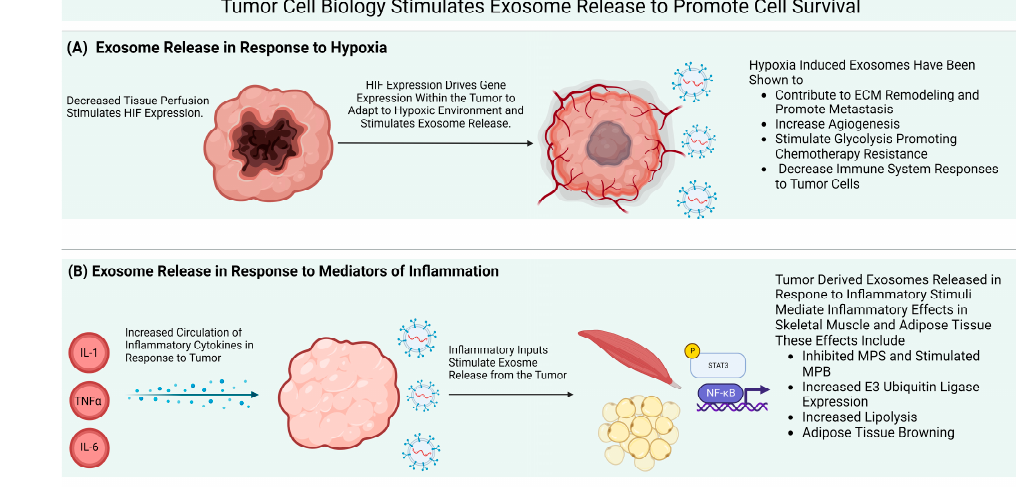
Figure 1. Exosome release in noncancerous cells is generally a pro-survival mechanism that is meant to relay signals of cellular stress throughout the body. Exosome release from tumor cells serves the same purpose, however tumor cells are exposed to a multitude of cellular stresses that stimulate exosome release. These exosomes interact with the tumor microenvironment and enter circulation where they exert systemic effects. ( A ) Tumor derived exosome release is stimulated by hypoxia to promote cell survival by altering the ECM components of the tumor microenvironment, stimulating angiogenesis, altering tumor and host cell metabolism, and altering local macrophage polarization. ( B ) Circulating inflammatory mediators also stimulate exosome release from tumor cells. These exosomes directly impact the MPS/MPB balance, increase E3 ubiquitin ligase expression, increase lipolysis and cause adipose tissue browning. Collectively, these effects illustrate a clear role of tumor derived exosomes in supporting cancer cell survival and contributing to the development of CC.